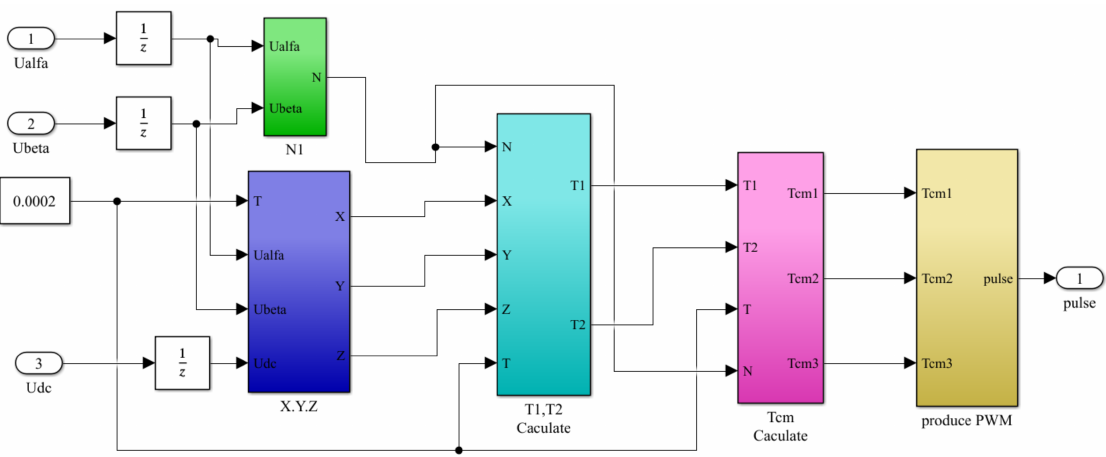
Figure 10. Simulation model of SVPWM